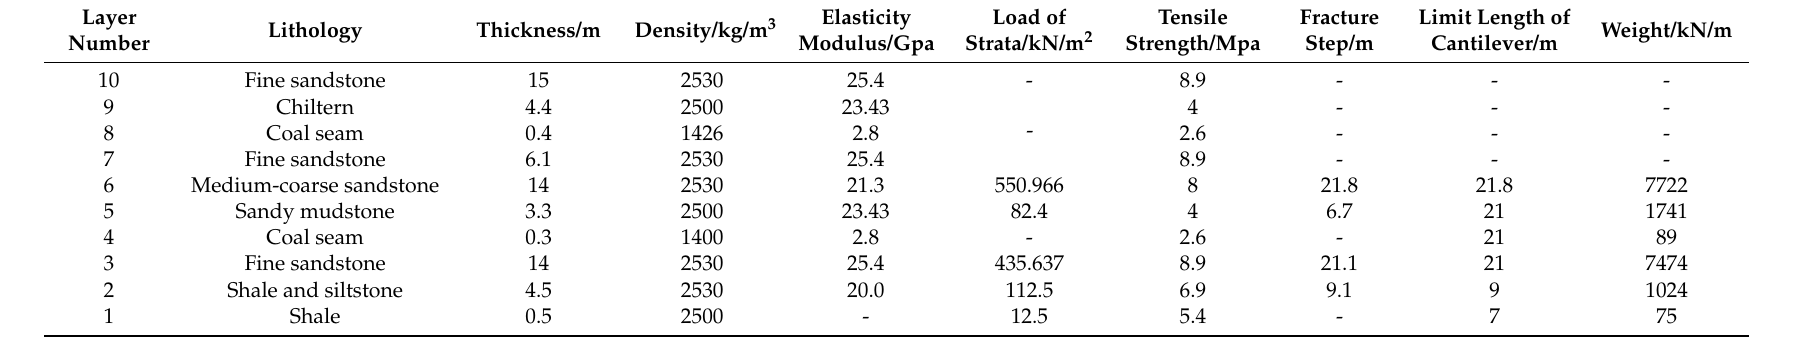
Table 2. Fracture step of each layer of the